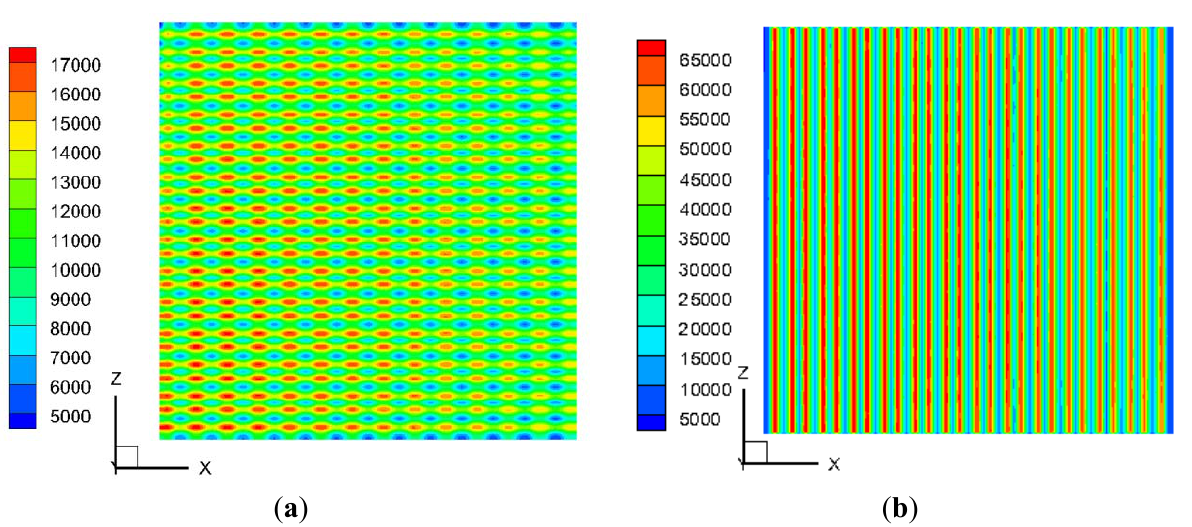
Figure 12. Current density (A/m 2 ) distribution in the active area of the cell for: ( a )